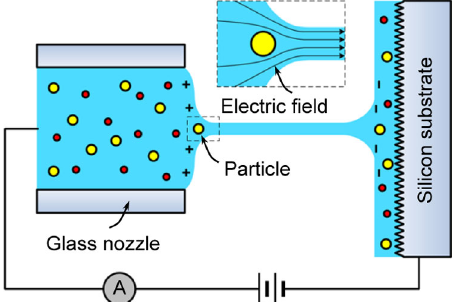
FIG. 1. Schematic of a resistive pulse sensing system in which particles are detected by the modulation of electrical current through a cone-jet bridge, a flexible sensing aperture that is not clogged